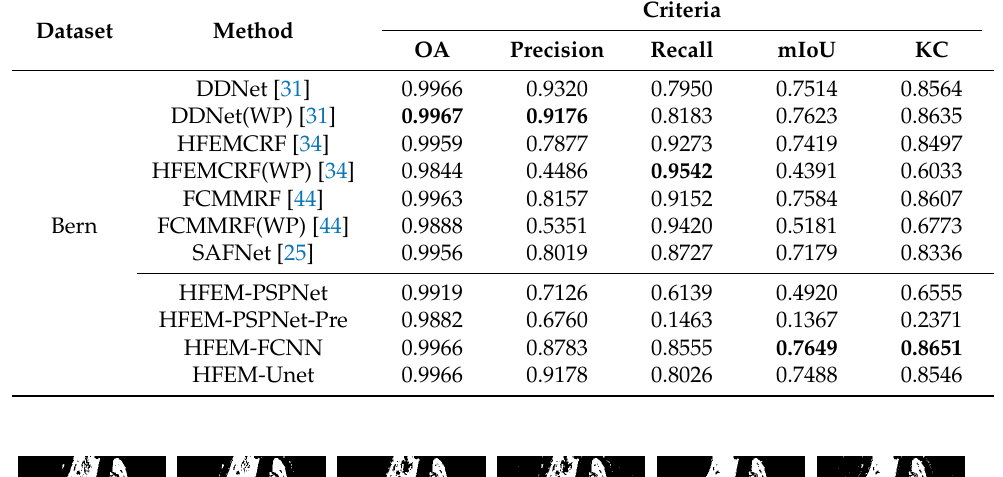
Table 2. The numerical results of Bern dataset.